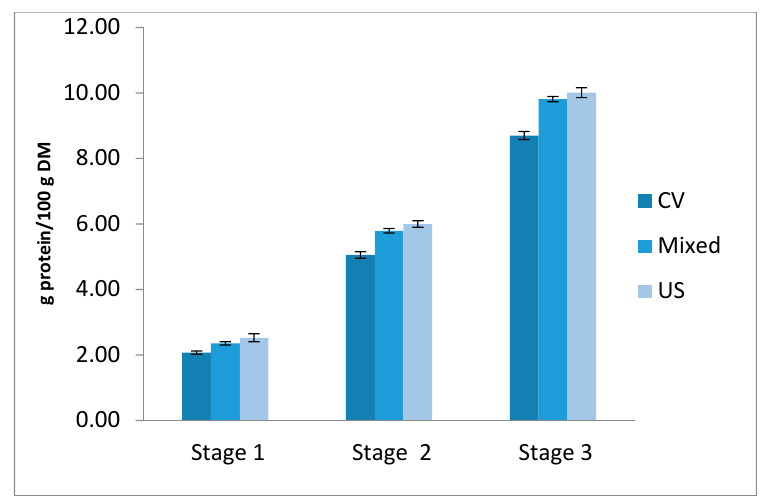
Figure 7. Cumulative extraction yields in multistage cross-current extraction: conventional (CV), under ultrasound (US) and mixed extraction conditions.